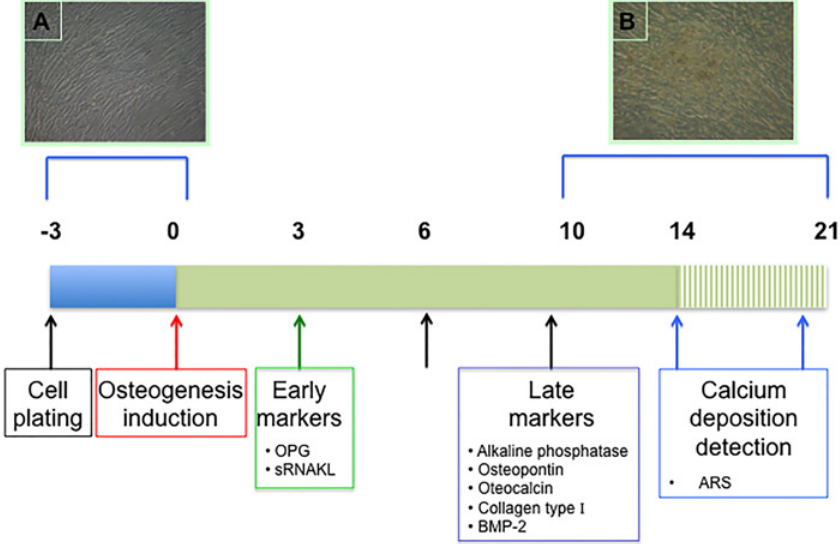
Figure 1. Flow chart of hMSCs culture set up and osteogenic induction. The horizontal line indicates the time period from cell plating until the beginning of calcification. Dashed bar indicates the detection of calcium deposition (ARS assay). Arrows indicate medium change with replacement of fresh serum from uremic patients or from healthy control donors. Boxes highlight specific marker detection or treatments. Early markers: OPG, sRANKL. Late markers: alkaline phosphatase, osteopontin, osteocalcin, collagen type I, BMP-2. Calcium deposition was detected by ARS assay. Differential morphology of hMSC before (fibroblast- like) and at the end of osteogenic differentiation process (spherical cells with calcium deposition) is also shown (panels A and B, respectively).